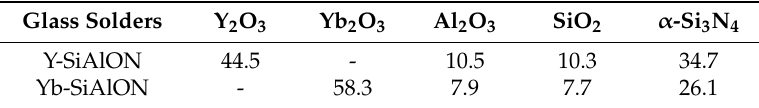
Table 1. Chemical composition of glass solders (wt %).